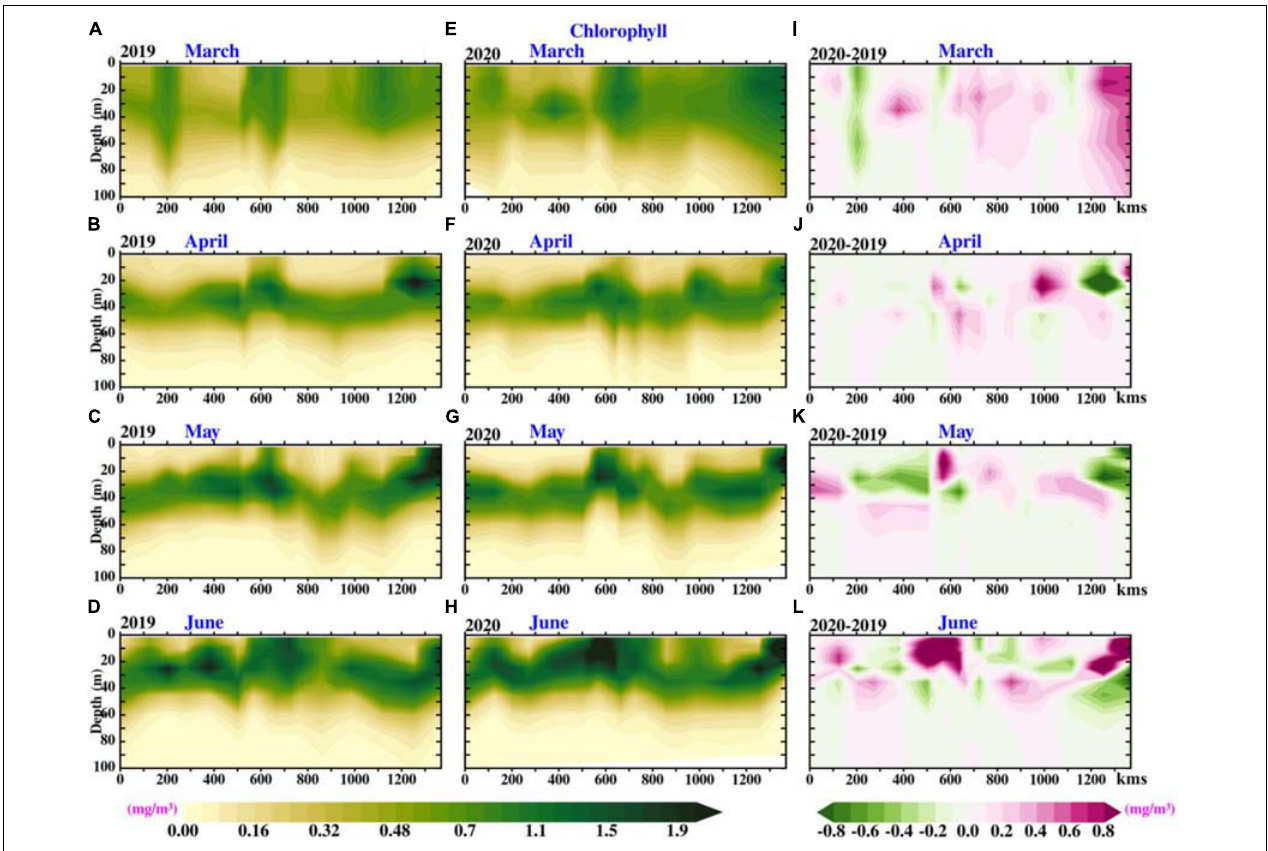
FIGURE 12 | Evolution of model-simulated Chl-a concentration along the 1,000 m isobath off Oman coast (as shown in Figure 1 ): (A–D) during the pre-pandemic period (March–June, 2019), (E–H) pandemic period (March–June, 2020), and (I–L) Chl-a concentration difference (pandemic–pre-pandemic